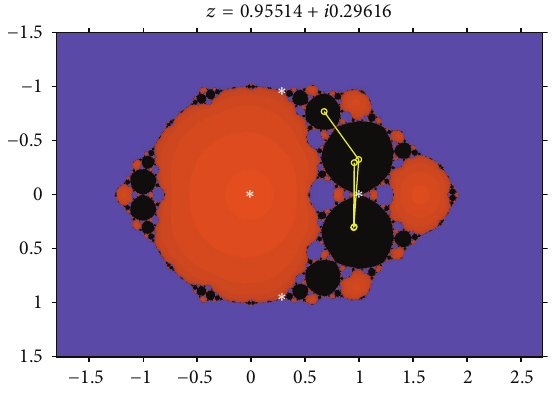
Figure 4: Dynamical plane for 𝛼 = (11/6) − 0.05